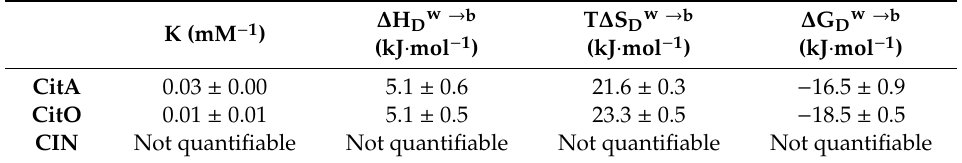
Table 1. Thermodynamic parameters characterizing the interactions of the main chemical EO components with PLPC / sitosterol large unilamellar vesicles (LUVs).